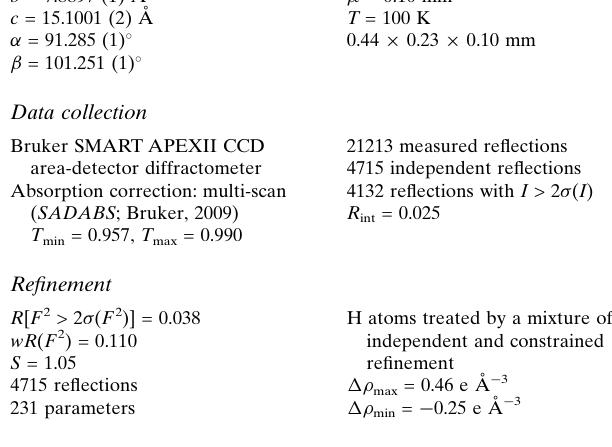
Data collection Bruker SMART APEXII CCD area-detector diffractometer Absorption correction: multi-scan ( SADABS ; Bruker, 2009) T min = 0.957, T max = 0.990